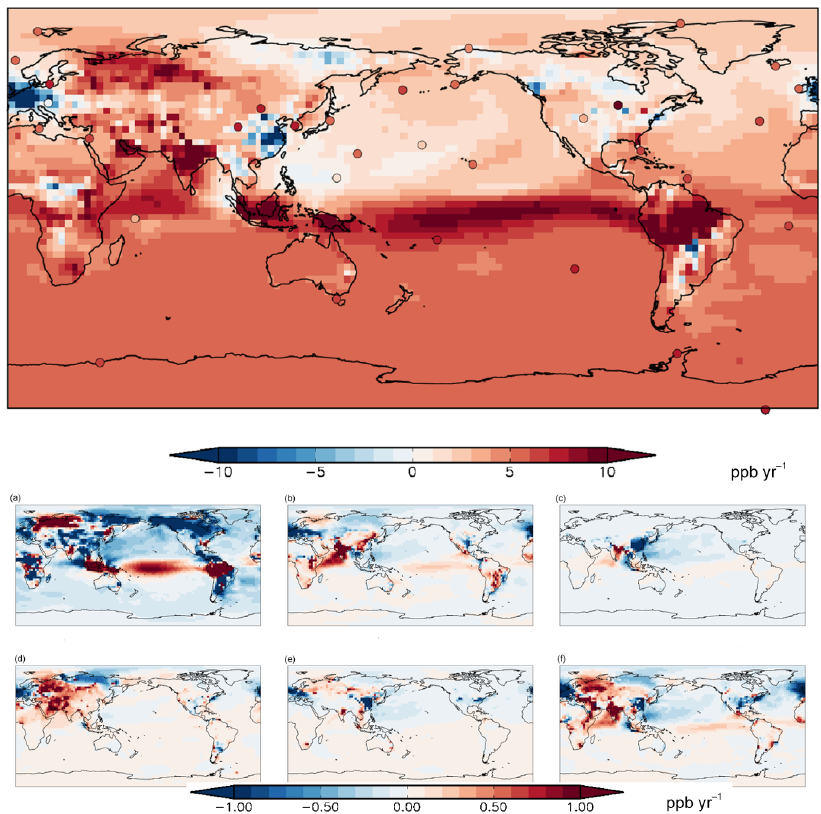
Figure 12. (Upper panel) Mean year-to-year growth (ppbyr − 1 ) in surface CH 4 in Oslo CTM3 over the period 1998–2000. The 32 circles show the observed growth rates over the same period. The stations picked for comparison are based on the criteria described in Sect. 2.3, and only observation sites that have measurements available for all months within the given time is included. (a – f) Mean year-to-year growth ppbyr − 1 ) of emission tracers in the same period. (a) Natural (wetlands + other natural + biomass burning), (b) enteric, (c) agricultural soils, (d) gas, (e) solid fuel, (f) the sum of all other anthropogenic